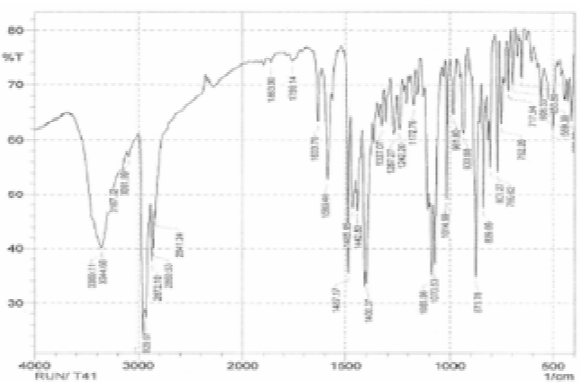
Fig. 2. Infrared spectra of lumefantrine - copper complex Table 1. Parasitaemia levels in P. berghei NK-65 infected mice treated with